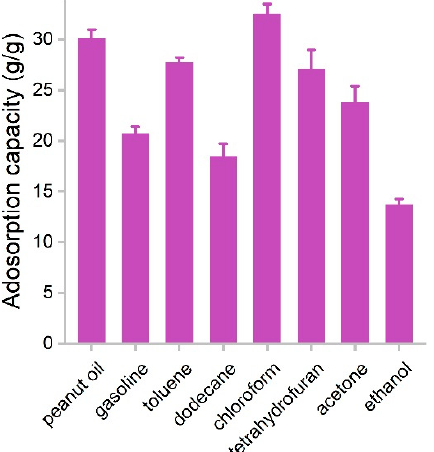
Figure 6. Adsorption capacities of PCS for oils and organic solvents. Table 1. Comparison of performance between PCS and similar sorbents.